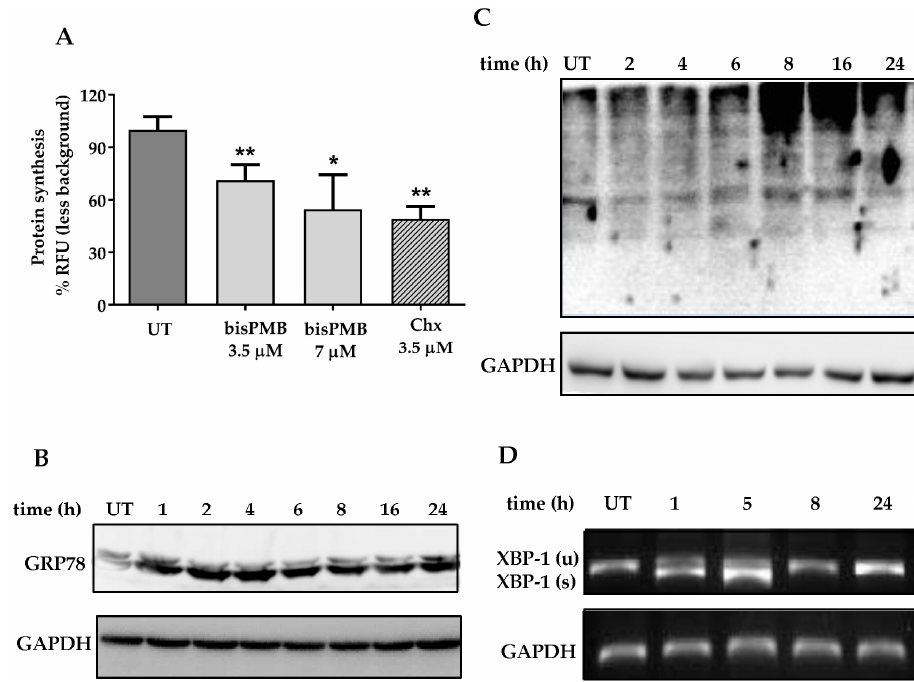
Figure 3. bisPMB activates the unfolded protein response in WHCO1 cells. ( A ) Protein synthesis quantification. WHCO1 cells were treated with bisPMB (IC 50 concentration) for 24 h and protein synthesis was quantified fluorometrically using the Click-it HPG Alexa Fluor Protein Synthesis